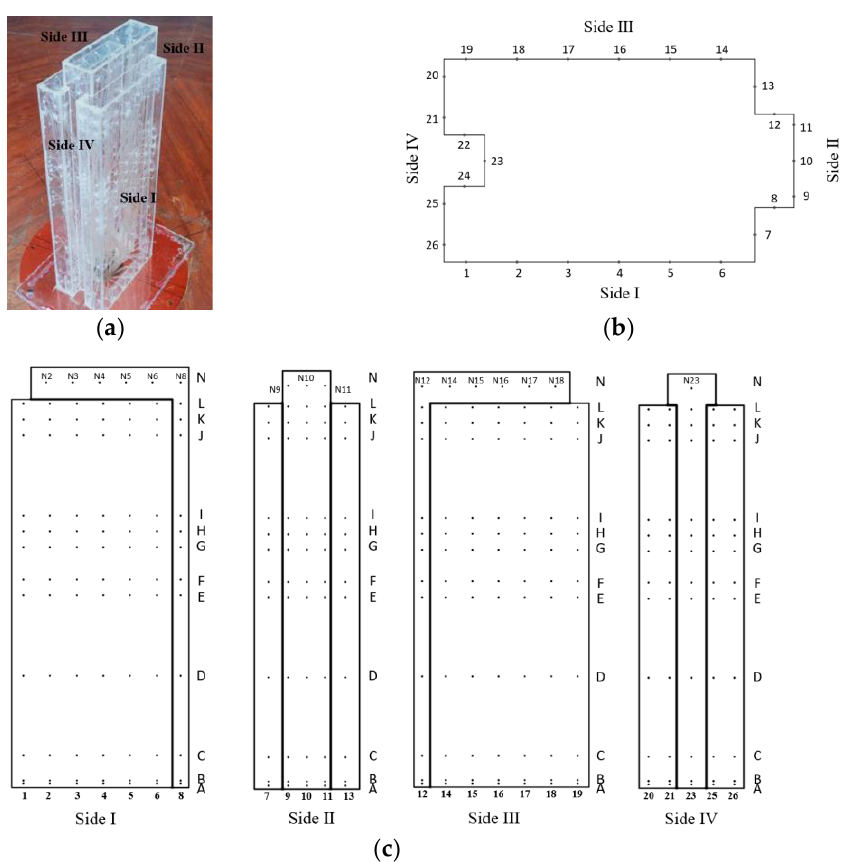
Figure 1. Arrangement of test points on the building model: ( a ) high-rise building model; ( b ) horizontal layer of the building; ( c ) four facades of the building.